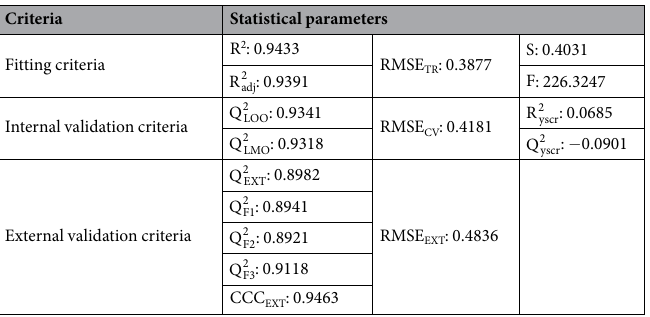
Table 3. Fitting, internal validation and external validation criteria for GA/MLR